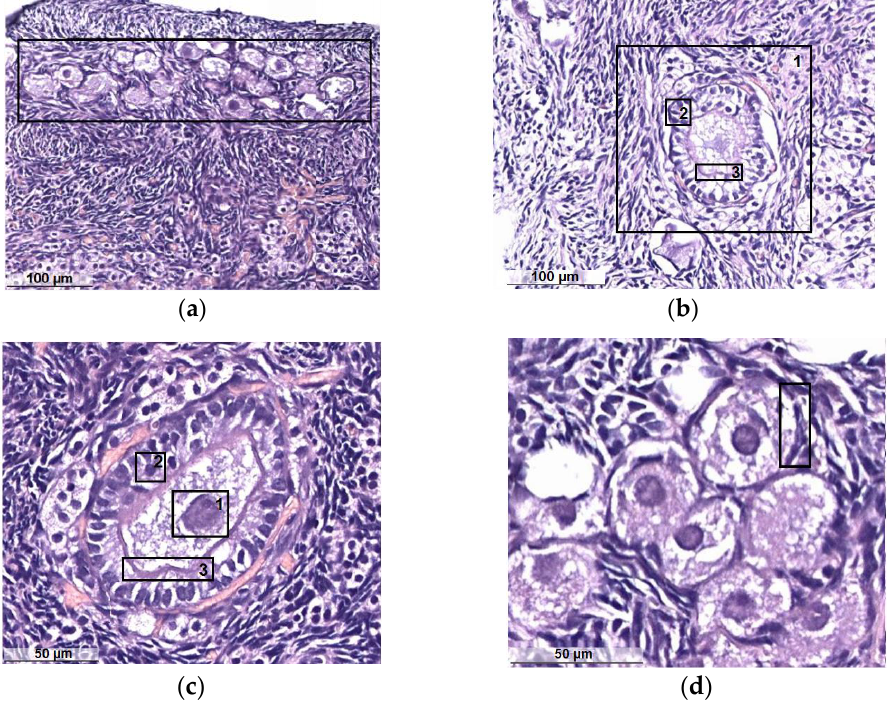
Figure 6. Histology of clinically healthy cat ovaries in the follicular phase: ( a ) primordial follicles; ( b ) primary follicle (1): granulosa of the follicle (2), shiny sheath of the follicle (3); ( c ) oocyte (1): granulosa of the oocyte (2), the shiny coat of the oocyte (3); ( d ) flattened follicular cells surrounding the oocyte.